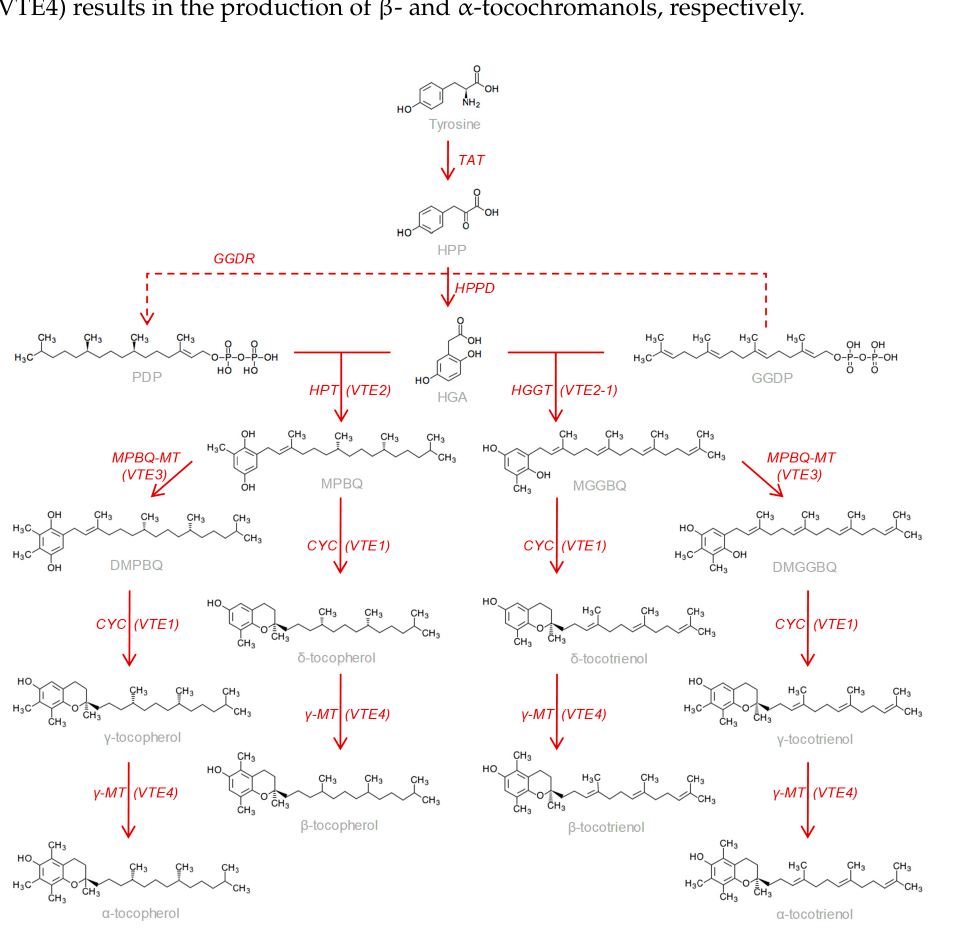
Figure 1. Biosynthetic pathway for tocopherols and tocotrienols in plants. Abbreviated intermediate metabolites are: hydroxyphenylpyruvate (HPP); phytyl diphosphate (PDP); homogentisate (HGA); geranylgeranyl diphosphate (GGDP); 2-methyl-6-phythylbenzoquinol (MPBQ); 2,3-dimethyl-6- phythylbenzoquinol (DMBQ); 2-methyl-6-geranylgeranylbenzoquinol (MGGBQ); 2,3-dimethyl-6- geranylgeranylbenzoquinol (DMGGBQ). The genes are the following: tyrosine aminotransferase (TAT); geranylgeranyl-diphosphate reductase (GGDR); 4-hydroxyphenylpyruvate dioxygenase (HPPD); homogentisate phytyltransferase (HPT / VTE2); homogentisate geranylgeranyltransferase (HGGT / VTE2-1); 2,3-dimethyl-6-phythylbenzoquinol methyltransferase (MPBQ-MT / VTE3); tocopherol cyclase (VTE1); γ -tocopherol methyltransferase